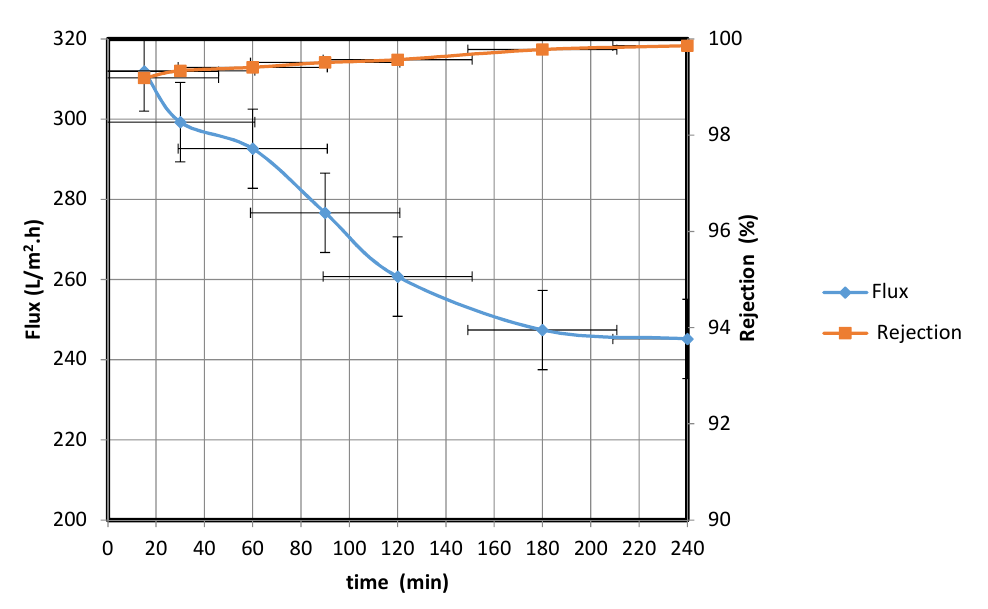
Figure 13. Flux rate of a real oil-contaminated water sample through fabricated membrane and percentage rejection at different times.